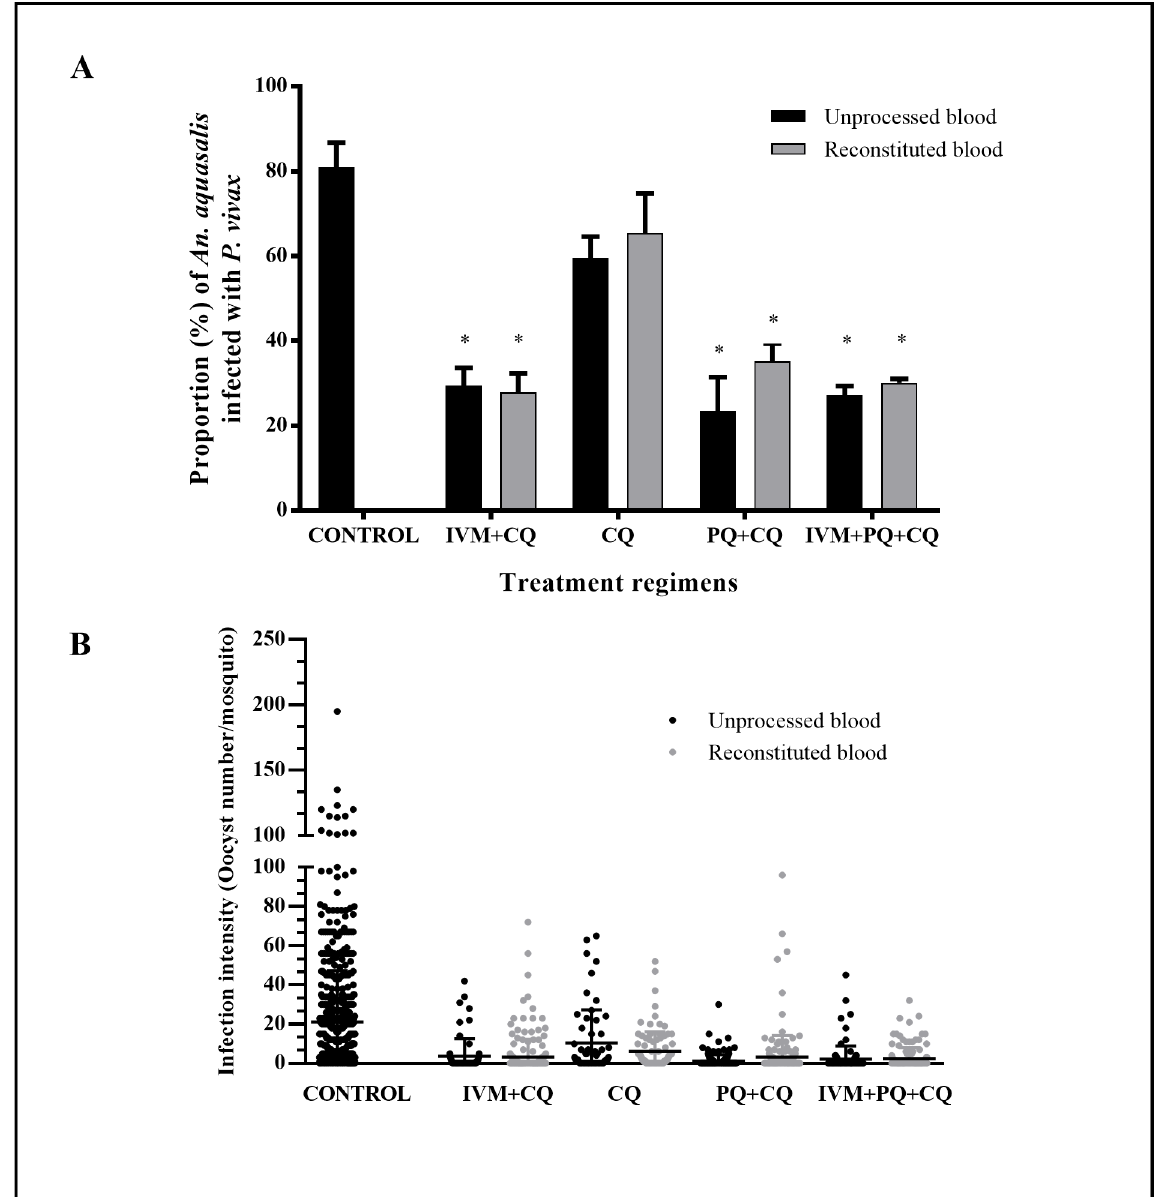
Fig 6. Plasmatic ivermectin and malaria drugs have a direct effect on Plasmodium vivax infection in Anopheles aquasalis . An . aquasalis female mosquitos were fed with unprocessed blood samples from P . vivax patients at time 0 (control) or 4 hours after different treatment regimens intake or with erythrocytes from P . vivax patients’ blood samples (before treatment) reconstituted to a hematocrit of 40% with the respective plasma after 4 hours of different treatment regimens intake. (A) The proportion of P . vivax infected mosquitos are presented as mean and standard deviation. Black bars represent the unprocessed blood and the grey bars represent the reconstitute samples. (B) The intensity of infection is presented as the number of oocysts per a single mosquito midgut (dots), black dots represent the unprocessed blood and the grey dots represent the reconstituted blood samples, and the black lines represent the median and standard error blood. Asterisks ( (cid:3) ) represent significant difference (P < 0.05) in relation to the control. (SD = 1.77), p < 0.001, reps = 3, n = 161], IVM+PQ+CQ by 89.1% [2.19 (SD = 0.96), p < 0.001, reps = 3, n = 99] and CQ alone by 56.5% [8.71 (SD = 8.92), p < 0.001, reps = 3, n = 58] com- pared with the control [20.02 (SD = 4.05), reps = 3, n = 615] (Fig 6B) and reconstituted with